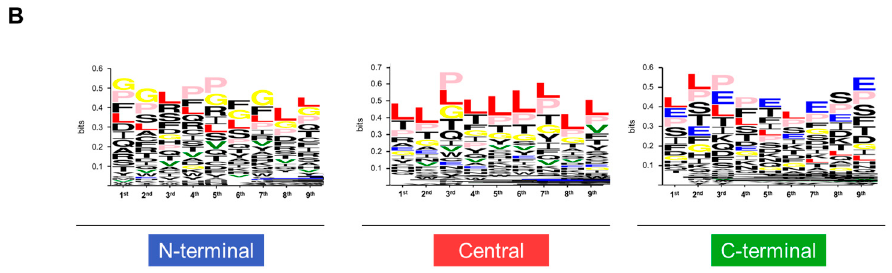
Figure 4. Distribution of different classes of amino acids that constitute reactive peptides according to different Tax regions. ( A ) Frequency of different classes of amino acids represented by heatmap according to the N-terminal, Central and C-terminal portions of Tax. ( B ) Frequency of amino acids from aligned peptide sequences generated in WEBLOGO according to the N-terminal, Central and C-terminal portions of Tax. Leucine (L): red; Valine (V): green; Glycine (G): yellow; Glutamic acid (E): blue; Proline (P): light pink.